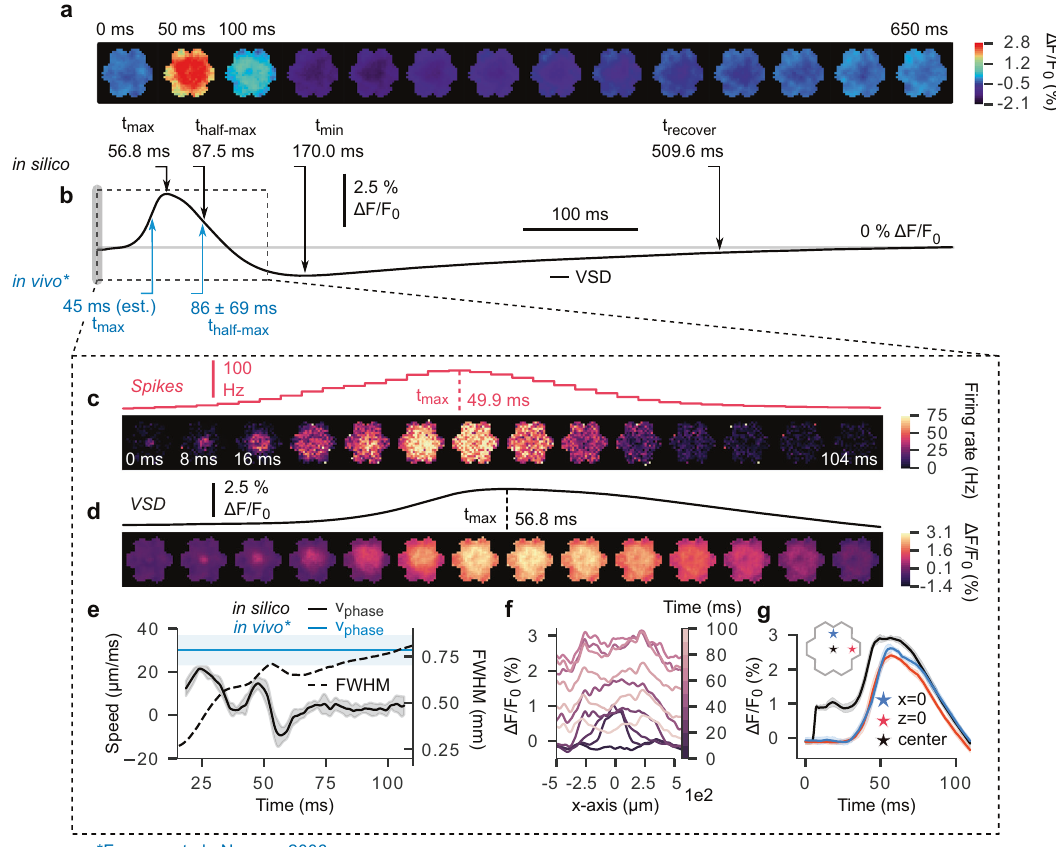
Fig. 2 Propagation of stimulus-evoked cortical activity. a 650 ms of stimulus-evoked VSD measurements in the “ mosaic ” . The stimulus consists of a single, coincident pulse of activity in 60 contiguous thalamic projection fi bers innervating the center of the interior microcircuit (delivered at t = 0 ms). b Time course of spatially averaged VSD signal in a . Upper arrows (black) indicate points of interest along the curve. From left to right: peak latency, half- maximum duration (time to decay to 50% of signal peak), time of signal minimum, recovery time (earliest time after minimum for amplitude to stably decay to within 10% of baseline). Bottom arrows (blue) indicate in vivo values for peak latency and half-maximum duration reported in literature. c Top: PSTH of spiking activity for time window (dashed box) indicated in b (3 ms bins). Bottom: pixel-wise PSTH (mean fi ring rate of all cells under each pixel) over same time window (8 ms bins). d Top: expanded view of time window (dashed box) indicated in b detailing ascending and descending phases of stimulus-evoked spatially averaged VSD signal. Bottom: same as above, but for spatially extended VSD signal, where each frame was computed by averaging activity in 8 ms intervals. e Activity wavefront propagation velocity (solid line, left axis), and wavefront size (full-width at half-maximum, dashed line, right axis). Blue horizontal line and shaded region show in vivo measurements of stimulus-evoked wavefront propagation velocity reported in literature. Solid blue line: mean value; shaded blue region: measurement range; shaded gray region: standard deviation ( n = 10 independent trials). f Spatiotemporal evolution of VSD signal along the x -axis ( z = 0, i.e., a horizontal line across the surface of the “ mosaic ” ). Lightening hue represents the passage of time. g Time course of VSD activation at speci fi c locations on the cortical surface. Blue star: circuit periphery along the y -axis. Red star: circuit periphery along the x -axis. Black star: circuit center. Colored error bands: standard deviation (n = 10 independent trials).